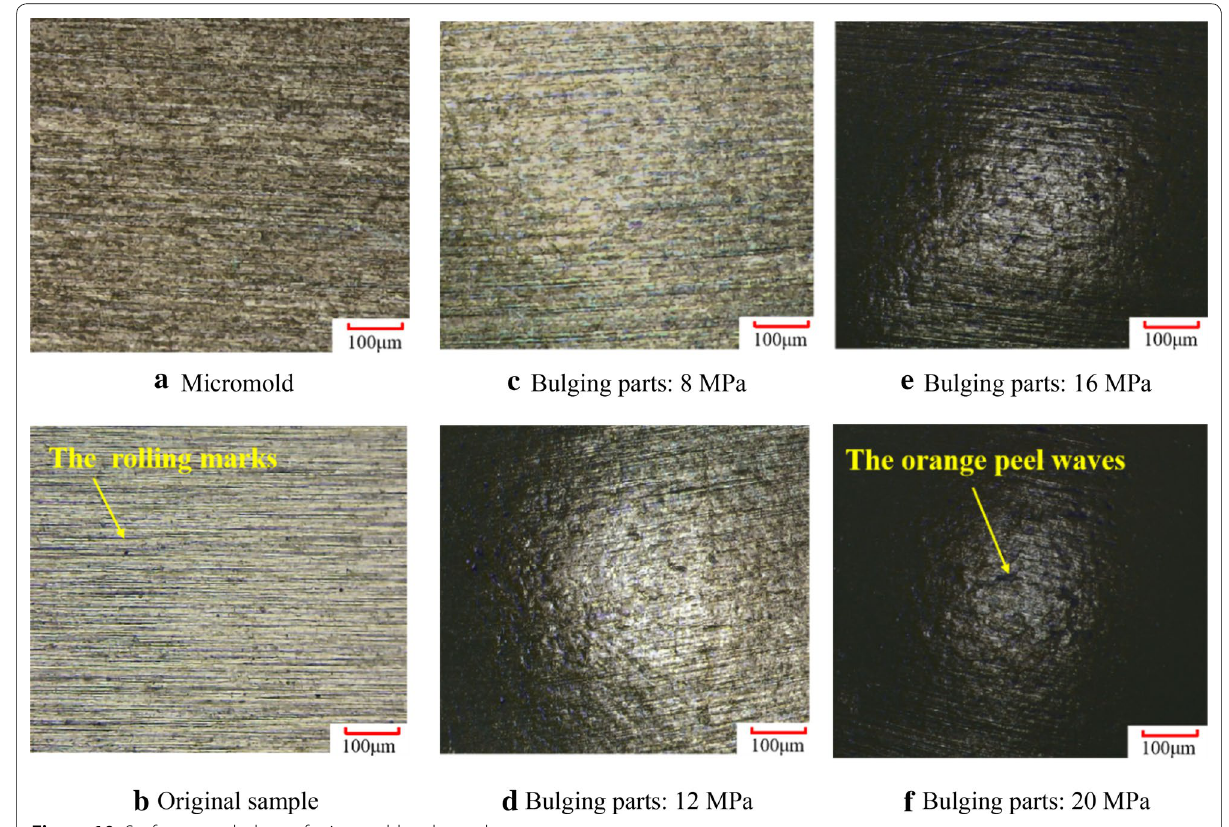
Figure 10 Surface morphology of micromold and